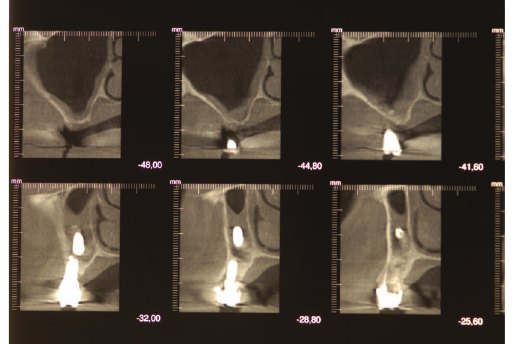
Figure 4: The osteotomy is performed by means of a piezoelectric instrument.